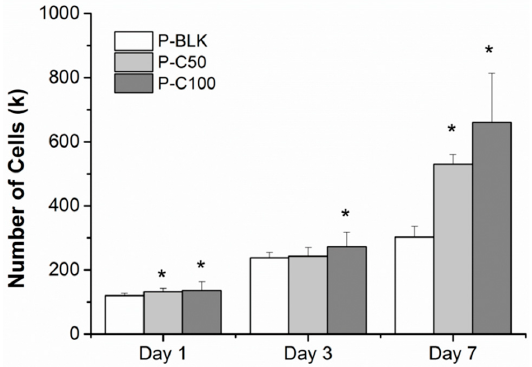
Figure 4. Human dermal fibroblasts (HDFs) proliferated on P-BLK (white), P-C50 (light gray), and P-C100 (gray) within seven days. * The cell number was significantly greater as compared with P-BLK ( p < 0.05). Error bar represents standard deviation of means; n = 3.